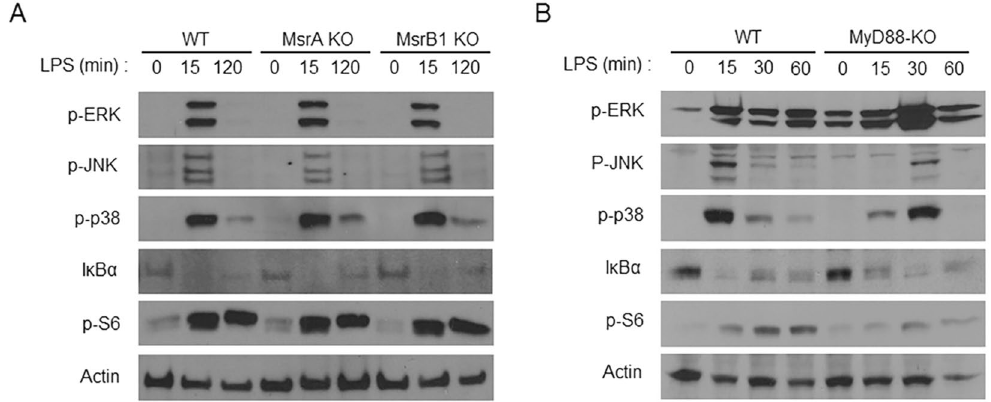
Figure 2. LPS-induced intracellular signaling pathways. ( A , B ) Western blot analysis of ERK, JNK, p38, and S6 phosphorylation and I κ B α degradation in WT, MsrA KO, and MsrB1 KO BMDMs ( A ) and WT and MyD88 KO BMDMs ( B ) after the indicated duration of LPS stimulation. Cropped gel images are shown and full-length gel images are included in Supplementary Figures S1 and S2.